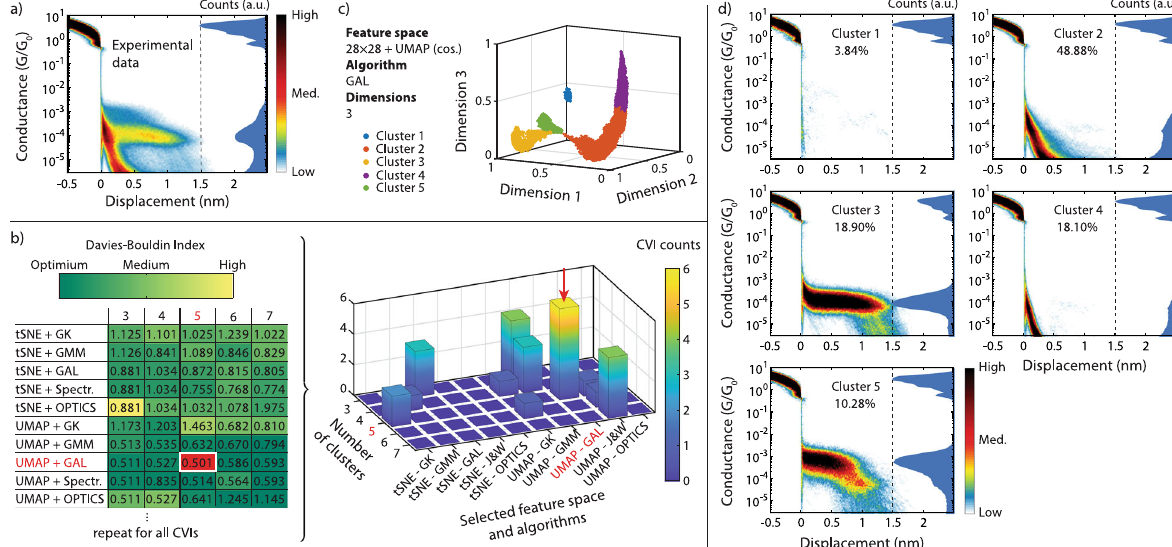
Fig. 3 Application of the work fl ow to measured mechanically controllable break-junction data. a Experimental 2D conductance-displacement histogram based on 10,000 breaking traces. The blue area represents the corresponding 1D conductance histogram. b Determination of the most suited feature space, clustering algorithm, and the optimal number of clusters using cluster validation indices (CVI). The feature space considered are 28 × 28 + t- distributed stochastic neighbor embedding (t-SNE) and 28 × 28 + uniform manifold approximation and projection (UMAP), both using a cosine (cos.) distance metric. The clustering algorithms considered are Gustafson – Kessel (GK), Gaussian mixed model (GMM), graph average linkage (GAL), spectral clustering following Jordan and Weiss (J&W), and Ordering Points To Identify the Clustering Structure (OPTICS). The heat map represents the Davies – Bouldin CVI, requiring a minimization of its value (red/white highlighted box). The histogram counts the occurrence of the feature space and clustering algorithm combinations, and of the optimal number of clusters, as predicted by the various CVIs. c Feature space constructed from the data of ( a ) using 28 × 28 + UMAP (cos.) and the GAL clustering method for fi ve clusters. d 1D conductance and 2D conductance-displacement histogram for the cluster assignment in ( c